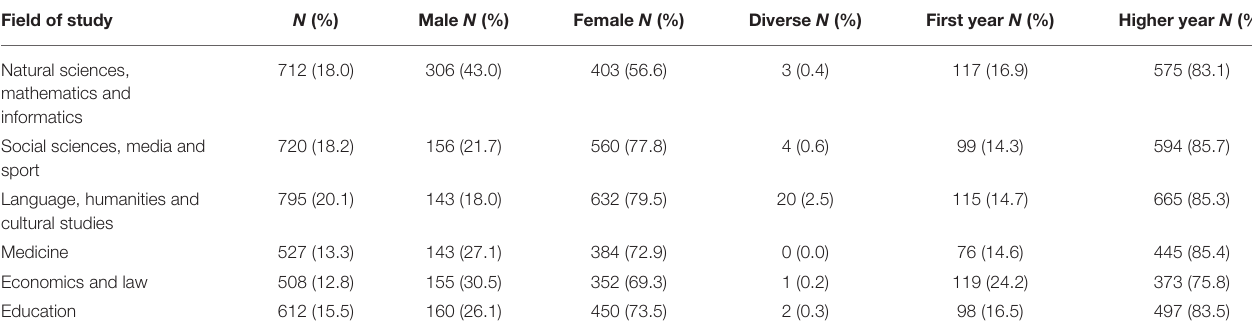
TABLE 2 | Sample characteristics relating to field of study, overall and stratified by gender and study semester. Field of